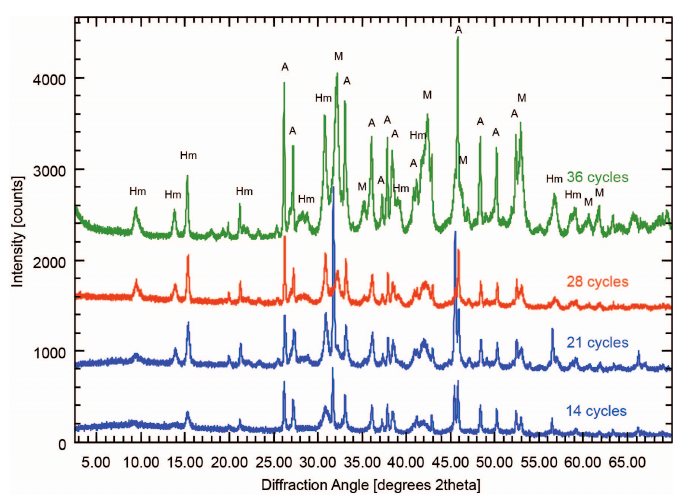
Figure 2. Powder X-ray diffractograms of reaction solids after 14, 21, 28 and 36 diel cycles (each indicated by a different colour) in the first (control) series of pH cycling experiments. The composition changes from aragonite and very high magnesium calcite to aragonite (A), magnesite (M) and hydromagnesite (Hm).